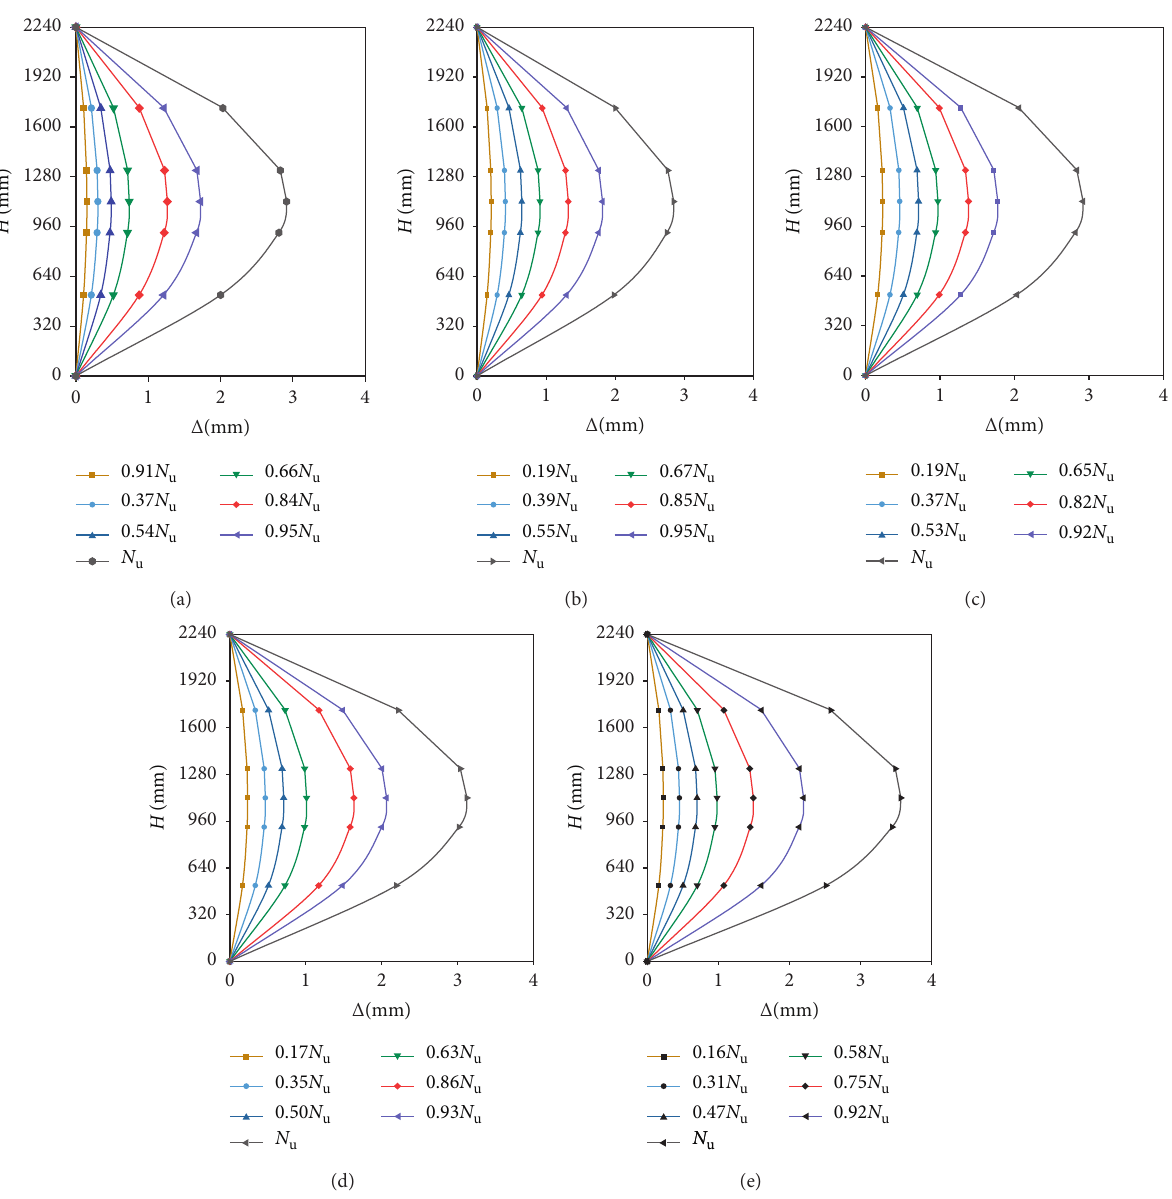
Figure 12: Comparisons of H - Δ curves of 5 specimens with different eccentricity. (a) STHCC-1. (b) STHCC-2. (c) STHCC-3. (d) STHCC-4. (e)